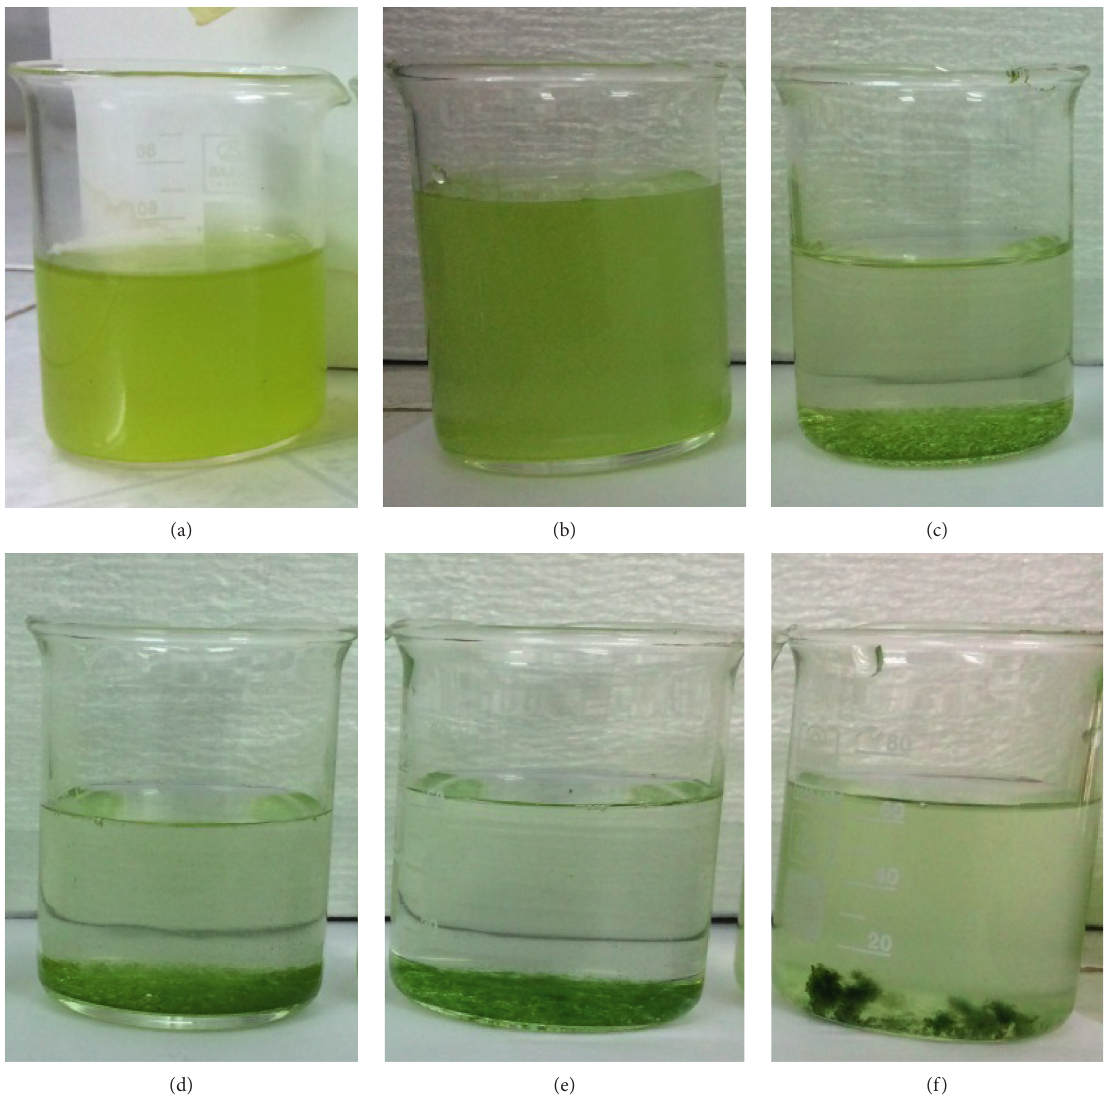
Figure 3: Flocculation activities in the control (a) and treatment with different concentrations of microalgae: 10mg/L (b), 20 mg/L (c), 30mg/L (d), 40 mg/L (e), and 60mg/L